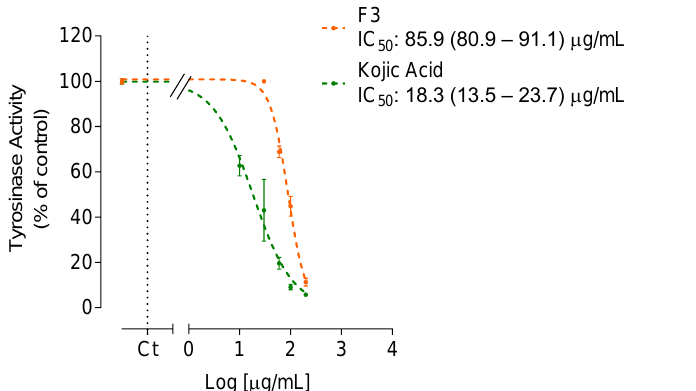
Figure 3. Dose-response curves (10 – 200 µg/mL) for enzymatic inhibitory activities of Saccorhiza pol- yschides fraction (F3) and kojic acid on tyrosinase, expressed as IC 50 value. polyschides fraction (F3) and kojic acid on tyrosinase, expressed as IC 50